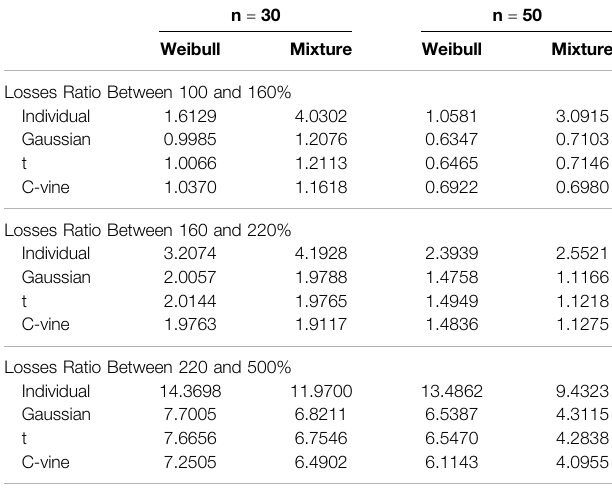
TABLE 13 | The average Mean Squared Error of aggregate losses at different layers for states in Group1.